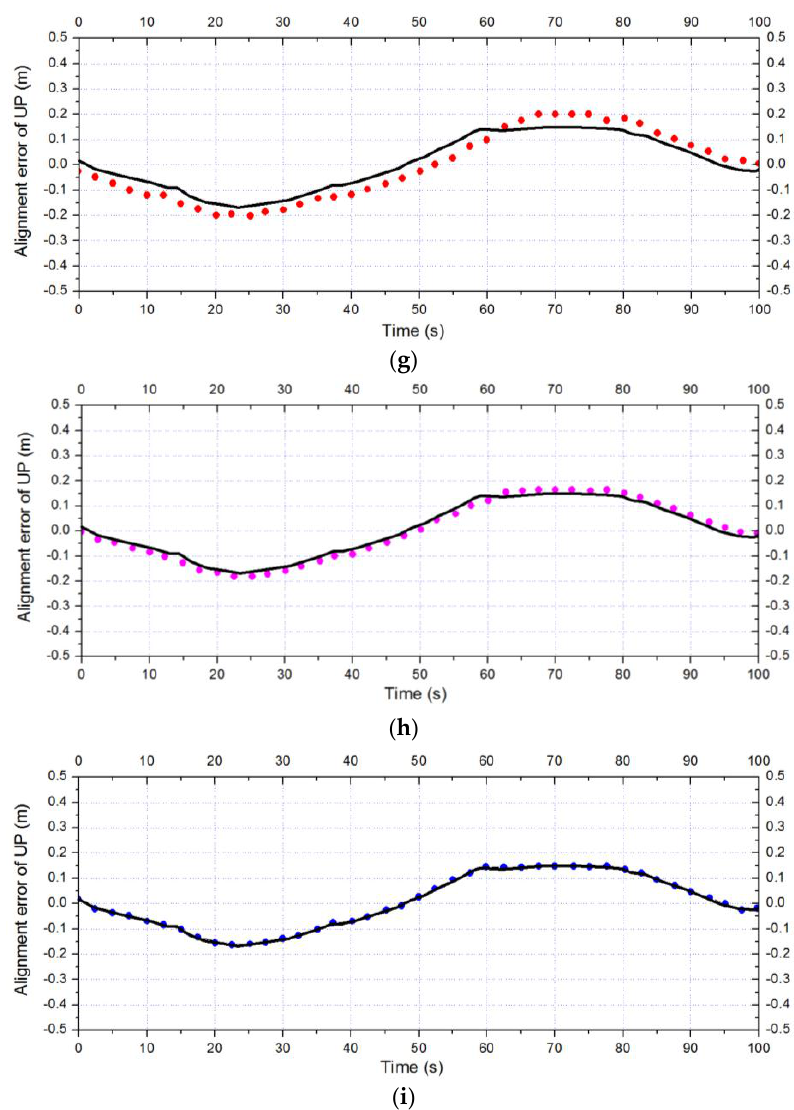
Figure 6. Time delay calibration using ICP-ISPKF for LiDAR-IMU. (a ) Initial alignment between LiDAR (red dots) and IMU(black line) in East orientation; ( b ) time delay calibration one time using ICP-ISPKF between LiDAR (magenta dots) and IMU(black line) in East orientation; ( c ) time delay calibration ten times using ICP-ISPKF between LiDAR (blue dots) and IMU(black line) in East orientation; ( d ) initial alignment between LiDAR (red dots) and IMU(black line) in North orientation; ( e ) time delay calibration one time using ICP-ISPKF between LiDAR (magenta dots) and IMU(black line) in North orientation; ( f ) time delay calibration ten times using ICP-ISPKF between LiDAR (blue dots) and IMU(black line) in North orientation; ( g ) initial alignment between LiDAR (red dots) and IMU(black line) in Up orientation; ( h ) time delay calibration one time using ICP-ISPKF between LiDAR (magenta dots) and IMU(black line) in Up orientation; ( i ) time delay calibration ten times using ICP-ISPKF between LiDAR (blue dots) and IMU(black line) in Up orientation.